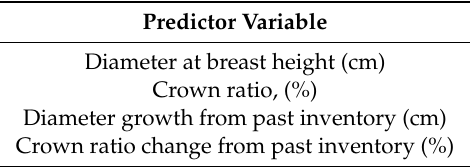
Table 1. List of predictor variables used in the generalized mixed